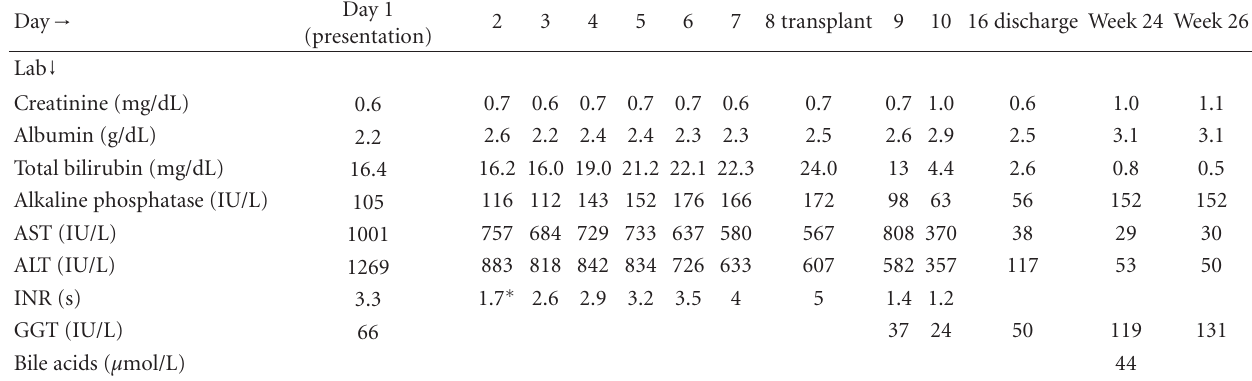
Table 1: Selected laboratory